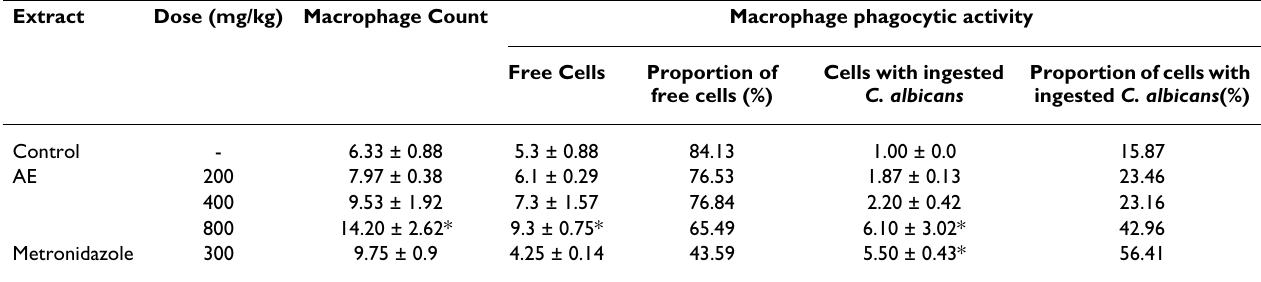
Table 8: Effect of extract on phagocytic activity of peritoneal macrophages Extract Dose (mg/kg) Macrophage Count